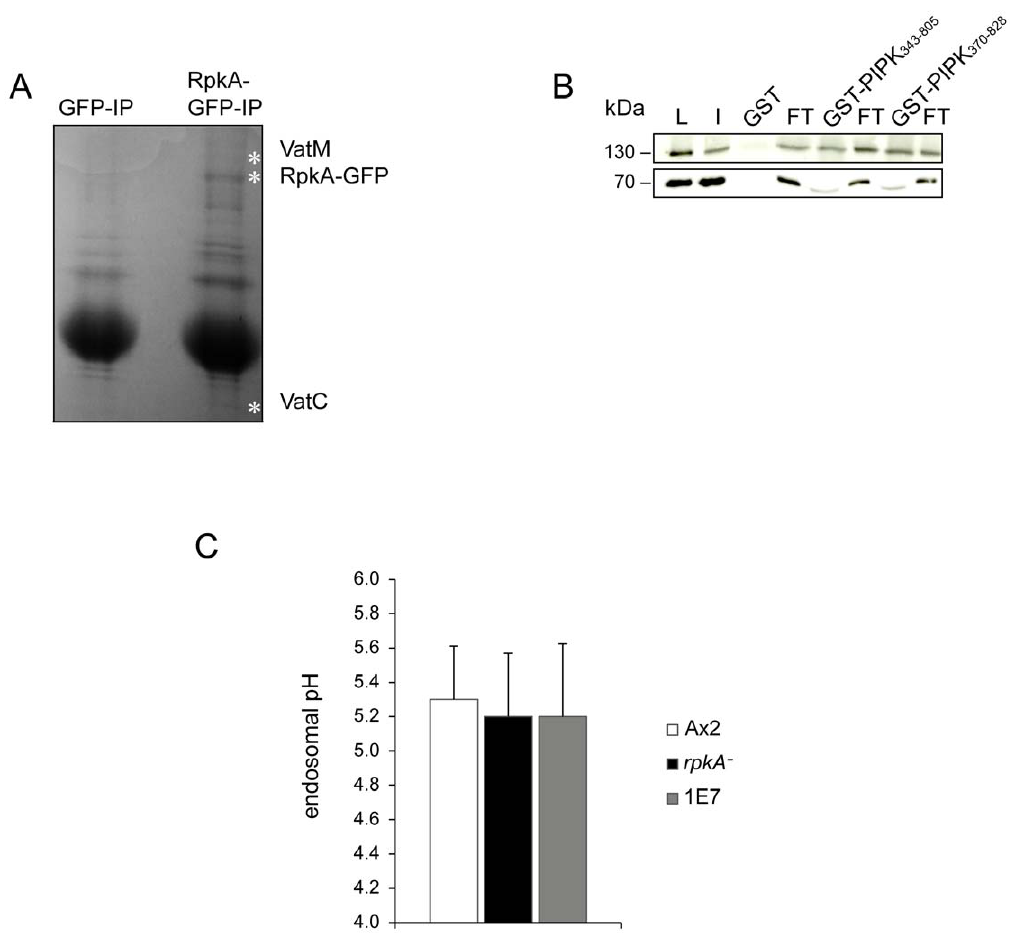
Figure 5. V-ATPase interacts with RpkA but average endosomal pH is uneffected in rpkA - . (A) V-ATPase co-immunoprecipitates with RpkA-GFP. Polyclonal GFP-antibodies were used for immunoprecipitation of either RpkA-GFP or GFP as a control. Proteins were separated by SDS- PAGE and stained with Coomassie Blue. VatM and VatC were detected as co-precipitates with RpkA-GFP by mass spectrometry. The positions of VatM, RpkA-GFP and VatC are indicated by white asterisks. (B) VatA and VatM-GFP specifically co-precipitate with GST-PIPK 343 – 805 and GST- PIPK 370 – 828 . GST, GST-PIPK 343 – 805 and GST-PIPK 370 – 828 were incubated with a lysate of rpkA - cells expressing VatM-GFP. Western blots of the pull down were probed using GFP-specific mAb K3-184 to detect VatM-GFP at 130 kDa and VatA specific mAb 223-35-2 to detect VatA at 70 kDa. The western blot shows the lysate of 2 6 10 5 cells (L), 10 m l of input (I), the pull downs (GST, GST-PIPK 343 – 805 and GST-PIPK 370 – 828 ) and respective flow through fractions (FT). In the lower panel a Coomassie-stained gel of the pull downs is shown. (C) Endosomal pH is unaffected in rpkA 2 . AX2, rpkA 2 and rescue strain 1E7 were incubated for 3 h with FITC-dextran as a pH probe. Then the excitation ratio at 495 nm/450 nm was measured and the endosomal pH was determined using a standard curve. Results are provided for quadruplet experiments 6